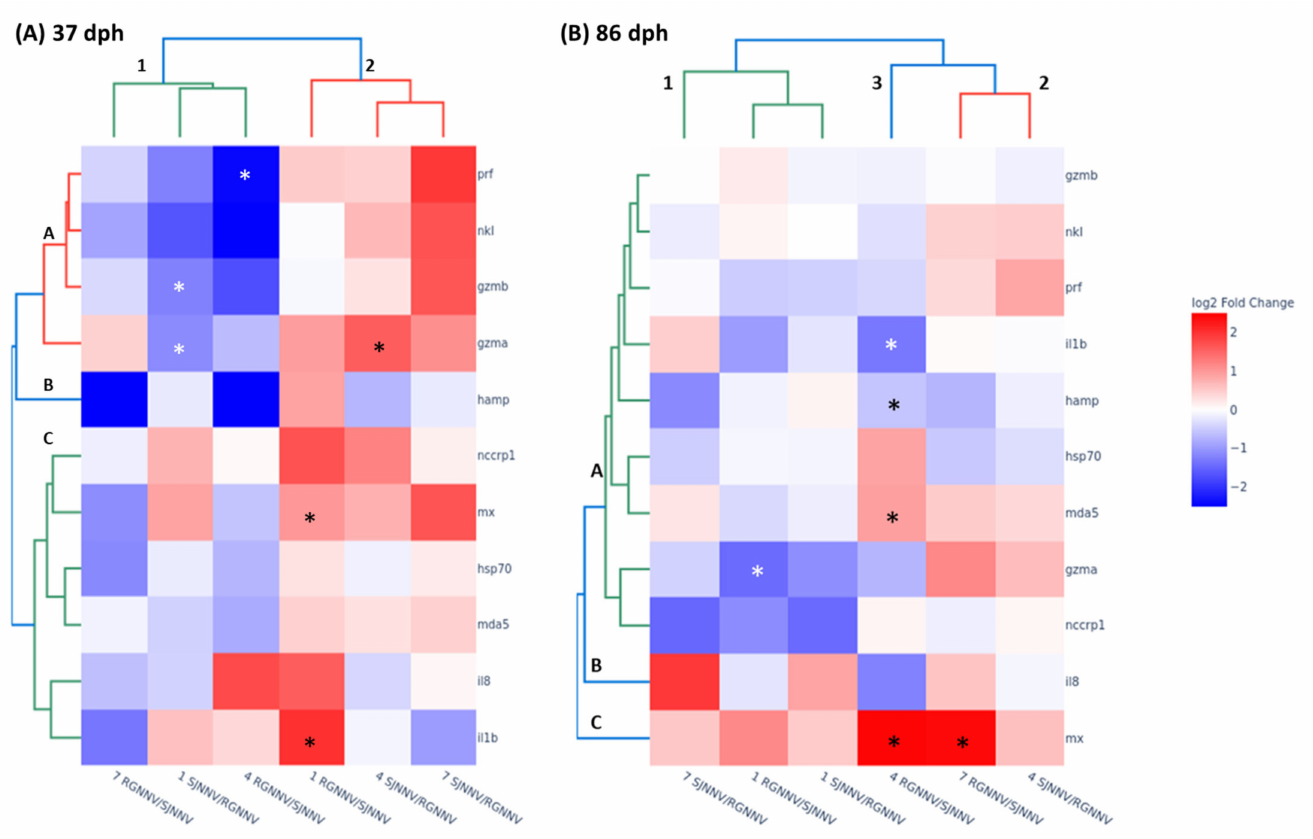
Figure 6. Seabream larvae of different ages show great variation in immune-related gene expression upon reassortant nodavirus (NNV) infection. Heatmap and two-way hierarchical clustering analysis (Euclidean method) of differentially expressed genes in 37 ( A ) and 86 ( B ) days post-hatching (dph) seabream larvae infected by immersion with 10 4 TCDI 50 / mL of RGNNV/SJNNV or SJNNV/RGNNV reassortants at 1, 4 and 7 days post-infection (dpi). Data are shown as mean of log2 fold change ( n = 5) with respect to the mock-infected group. Asterisks (*) represent statistical differences between control and NNV-infected groups according to a t -Student test ( p < 0.05). Letters inside figures (A, B, C) denote clusters for genes and numbers inside figures (1, 2, 3) denote clusters for samples. mx , interferon-induced GTP-binding protein Mx; mda5 , melanoma differentiation-associated protein 5; hsp70 , heat-shock protein 70; il1b , interleukin 1 beta; il8 , interleukin 8; hamp , hepcidin antimicrobial peptide; nccrp1 , non-specific cytotoxic cell receptor protein 1; nkl , NK-lysin; prf , perforin; gzma , granzyme A; gzmb , granzyme